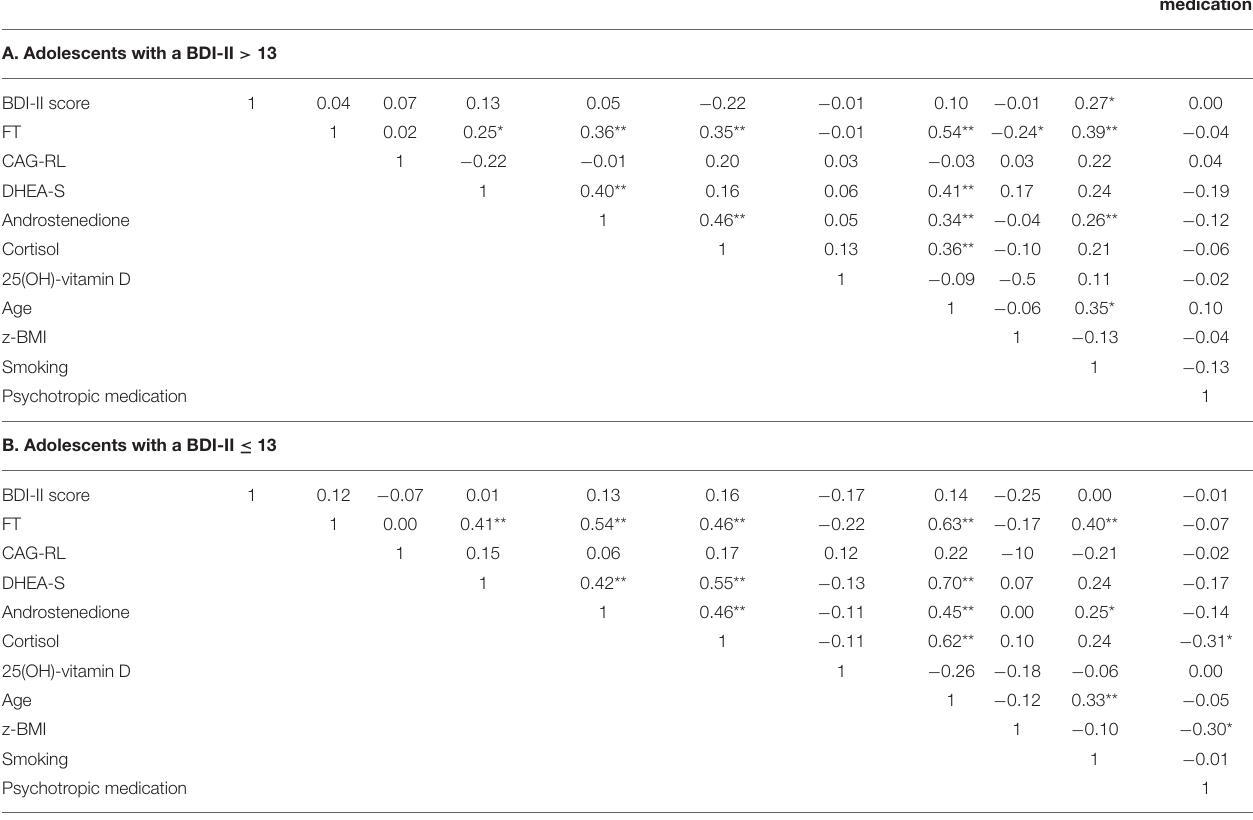
Table 3 | Bivariate